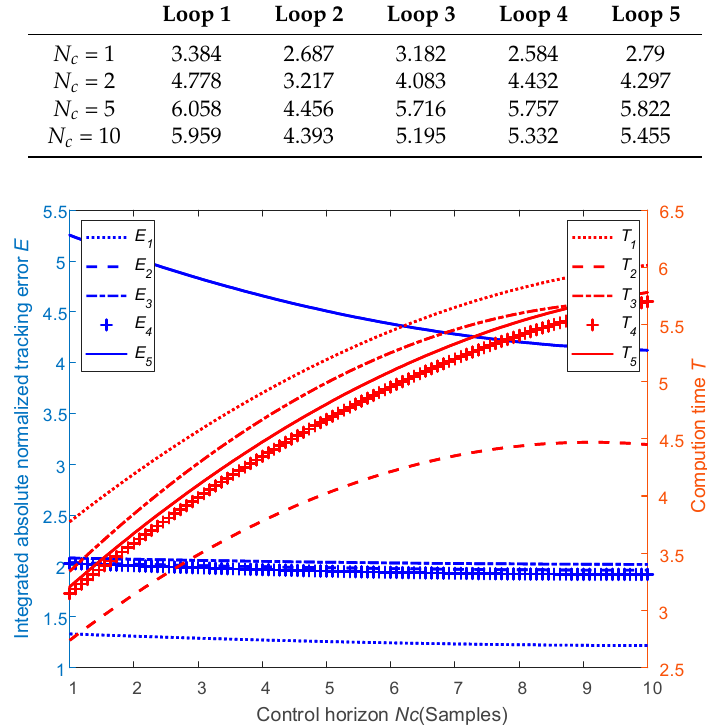
Figure 5. Computation time T i (blue line) and integrated absolute normalized tracking error E i (red line) in the five loops i ( i = 1,2,...,5) for different control horizon values.